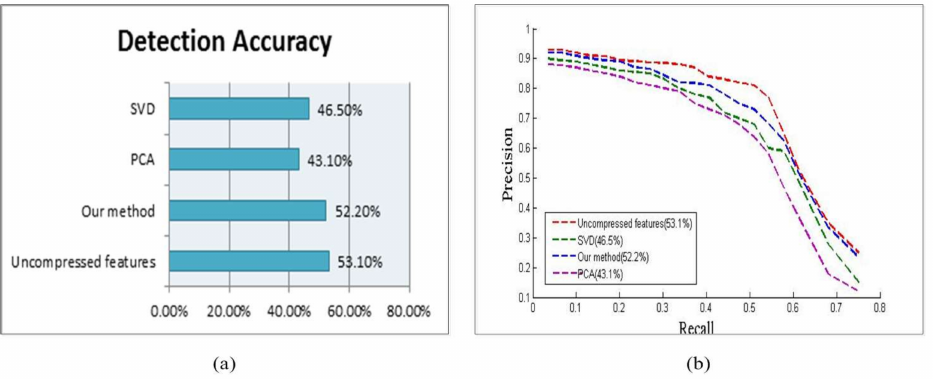
Figure 11. ( a ) Illustration of the detection accuracy of four kinds of features; and ( b ) the precision-recall